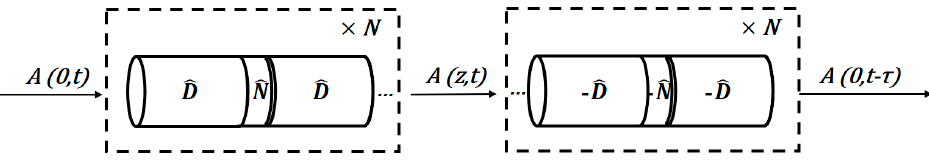
Figure 7. Schematic of digital back propagation (DBP) using the symmetric split-step method (SSM).